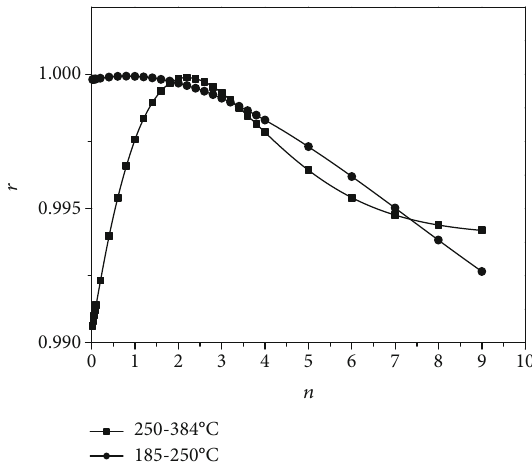
Figure 6: Dry distillated coal tar combustion reaction rate correlation. Table 2: Dry distillated coal tar combustion kinetic parameters at the no. 1